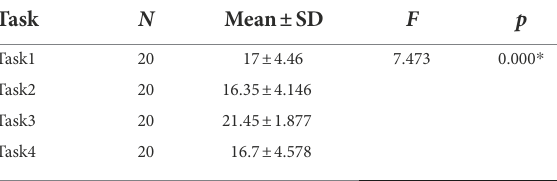
TABLE 2 One-way ANOVA within the NOEE group.